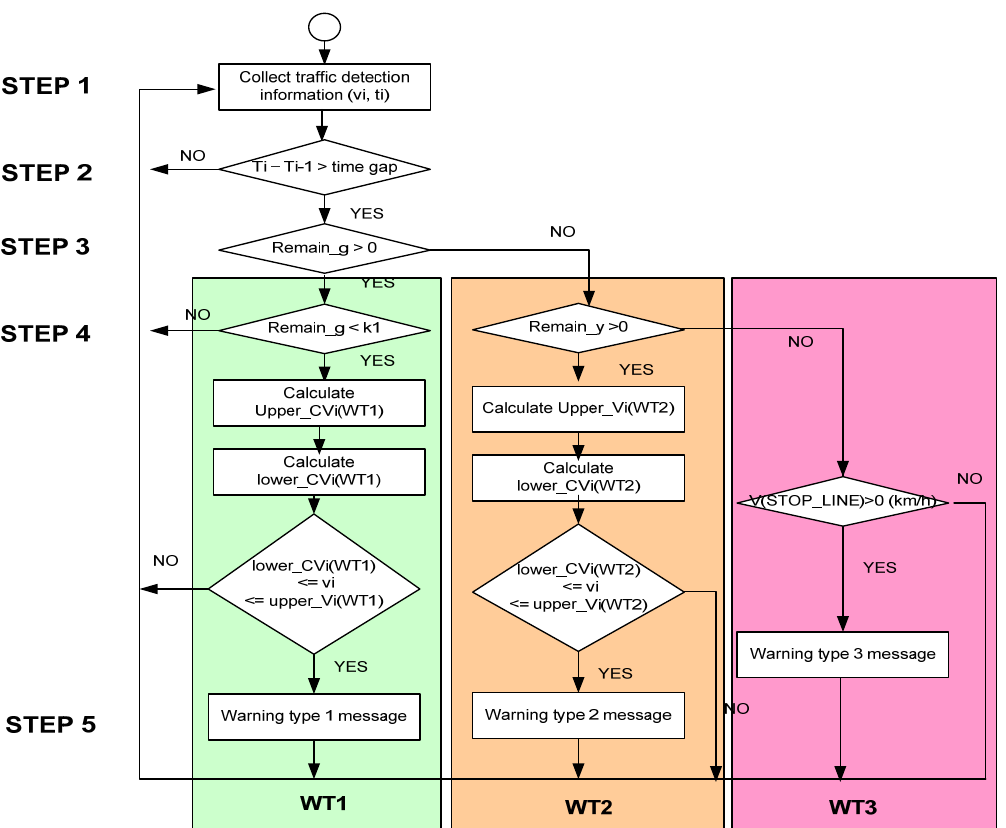
Figure 6. Flowchart for the red-light violation warning